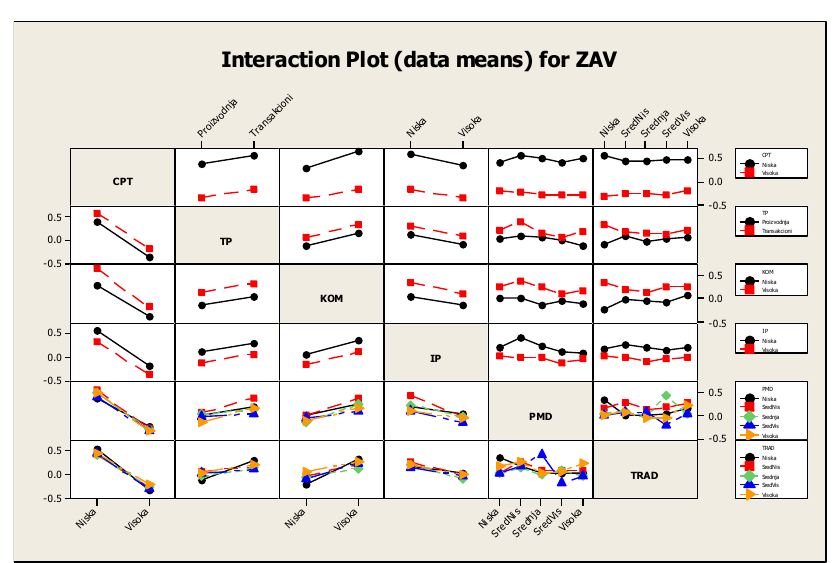
Fig. 8. Interactions - ZAV (project